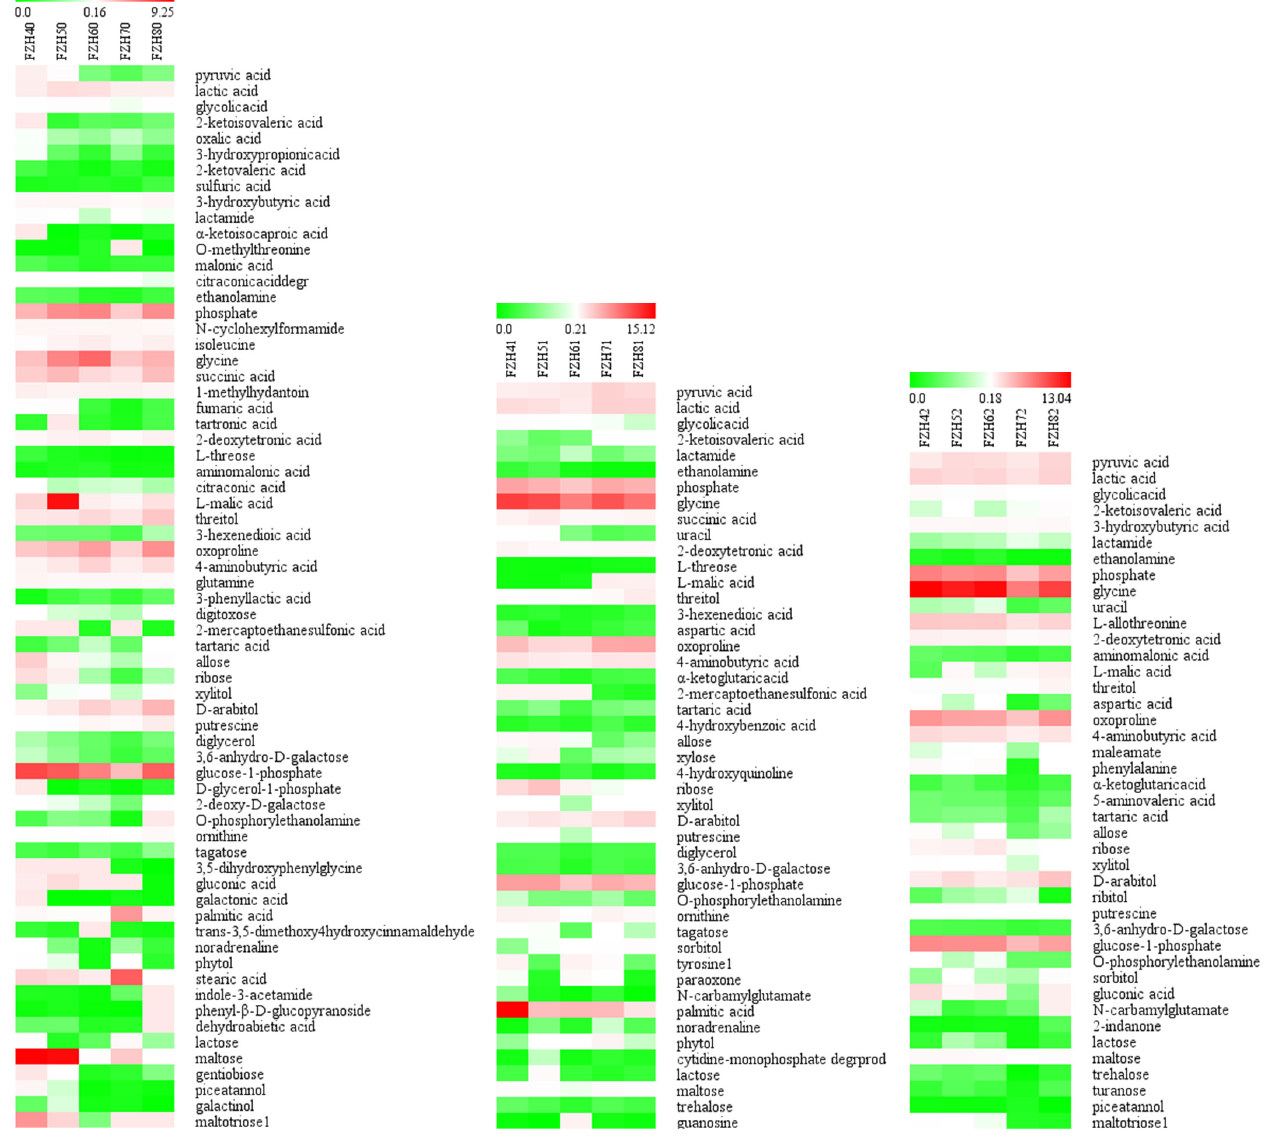
Figure 7. Heatmap of the abundance of marked metabolites in the fermentation broth of Epichloë sinensis when exposed to 0, 0.1 or 0.2 mmol/L selenium. Red and green blocks indicate higher and lower metabolite levels (see scale bar). FZH40, FZH50, FZH60, FZH70, and FZH80 represent fermentation broth in absence of Se for weeks 4, 5, 6, 7, and 8, respectively. FZH41, FZH51, FZH61, FZH71, and FZH81 represent fermentation broth in the presence of 0.1 mmol/L Se between weeks 4 to 8. FZH42, FZH52, FZH62, FZH72, and FZH82 represent fermentation broth in the presence of 0.2 mmol/L Se during weeks 4 to 8.